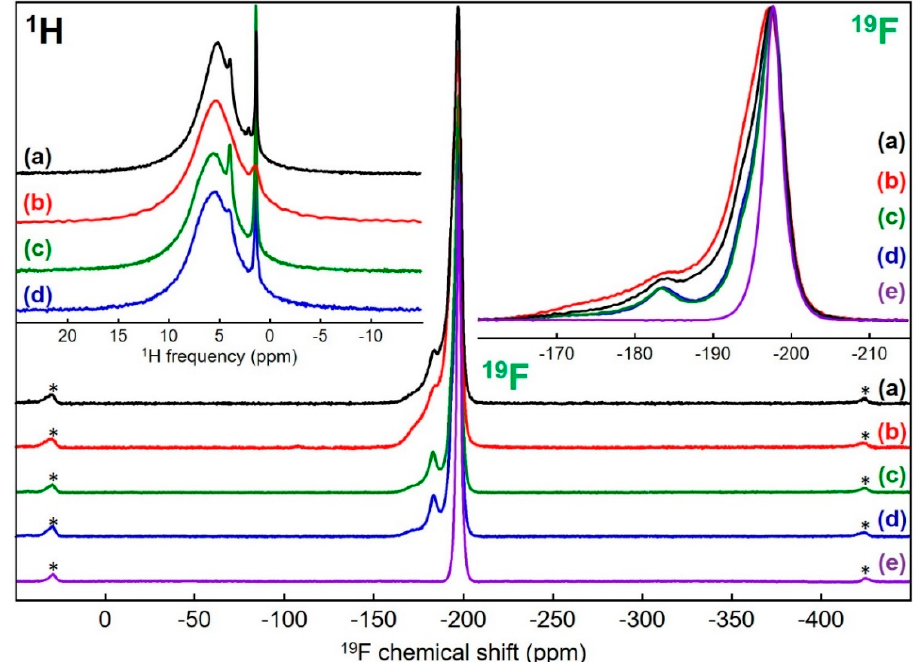
Figure 6. 19 F and 1 H (in the inset on the left) solid-state MAS (64 kHz and 60 kHz, respectively) NMR spectra of MgF 2 samples prepared from ( a ) acetate, ( b ) carbonate, ( c ) chloride and ( d ) nitrate magnesium precursors, before the HF activation step and for 19 F of ( e ) a micro crystalline sample of MgF 2 . The isotropic lines of the 19 F spectra are expanded in the inset on the right. The star symbols on the 19 F spectra indicate the spinning